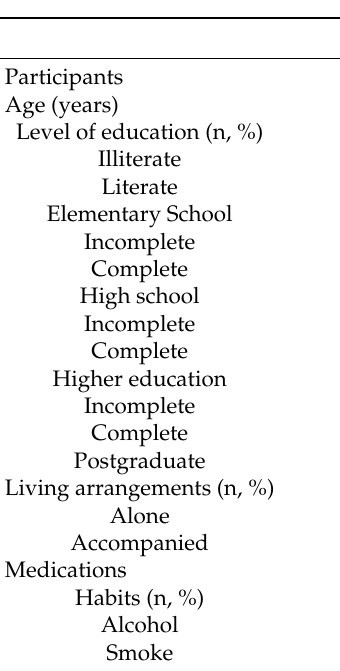
Table 1. Sample characteristics.